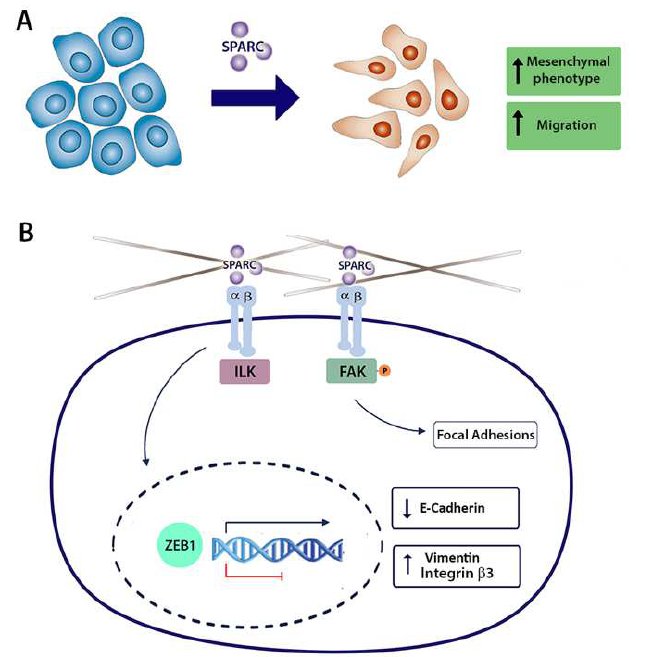
Figure 6. Proposed model for the effect of SPARC on E-cadherin expression and migration mediated by integrin α v β 3 and the transcription factor ZEB1 in prostate cancer cells. ( A ) SPARC induces func- tional changes associated with the epithelial–mesenchymal transition (EMT): increased mesenchymal phenotype and enhanced motility. ( B ) Because SPARC requires the activity of integrin α v β 3 to induce E-cadherin downregulation and cell migration, SPARC effect could be a result of the direct or indirect association of SPARC and the integrin α v β 3 . Through integrin α v β 3 , SPARC could activate the focal adhesion kinase (FAK) and the integrin-linked kinase (ILK). FAK activation by phosphorylation on Y925 promotes focal adhesion turnover, enhancing motility. On the other hand, through FAK, ILK, or other downstream molecules, SPARC could be promoting the expression of the EMT transcription factor ZEB1. The transcription factor ZEB1 inhibits the expression of E-cadherin and induces the expression of mesenchymal markers such as